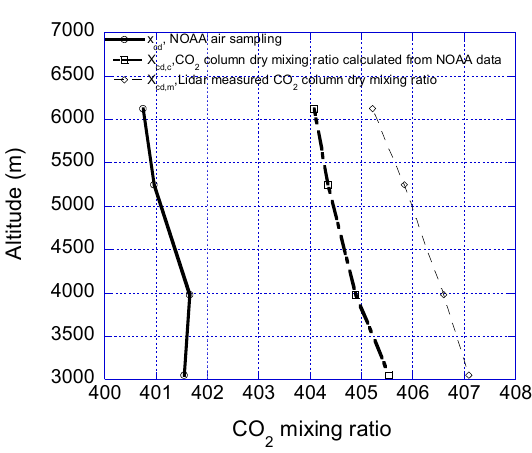
Fig. 3. CO 2 mixing ratio versus altitude calculated from NOAA flask sample data and from the IPDA lidar